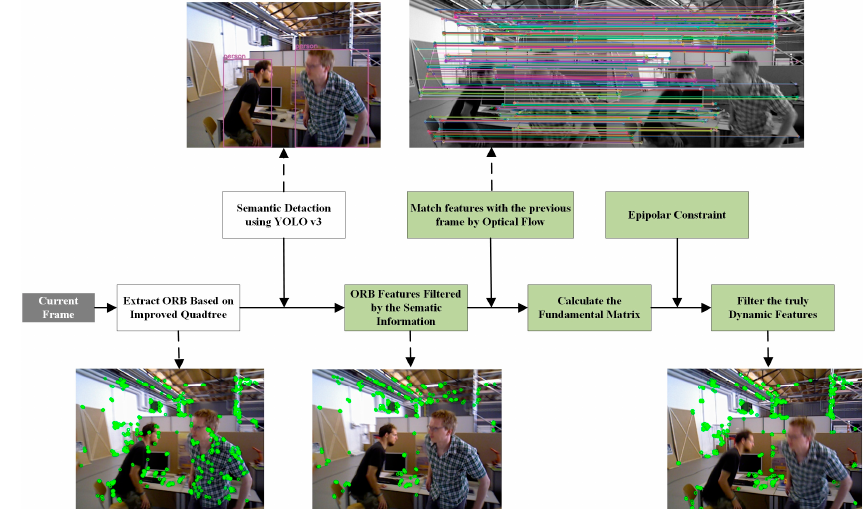
Figure 3. Flow chart of the semantic and geometric constraints’ algorithm. Features extracted from objects labelled as dynamic are first screened by their semantic information. Then, the stable fundamentals are calculated by the remaining features. Finally, all the real dynamic features are filtered out by the epipolar constraint.